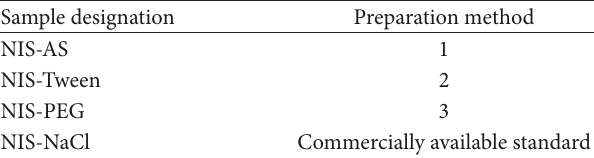
Table 1: Designation of standard and prepared